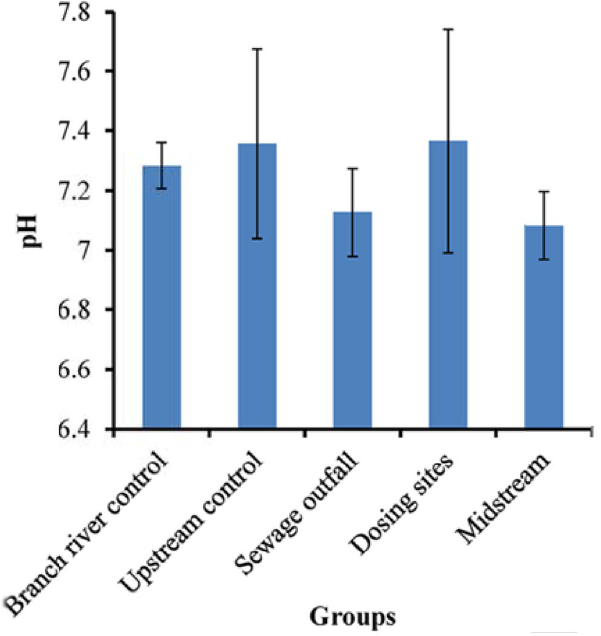
Figure 1. The mean pH of river water in different groups. The error bars represent standard